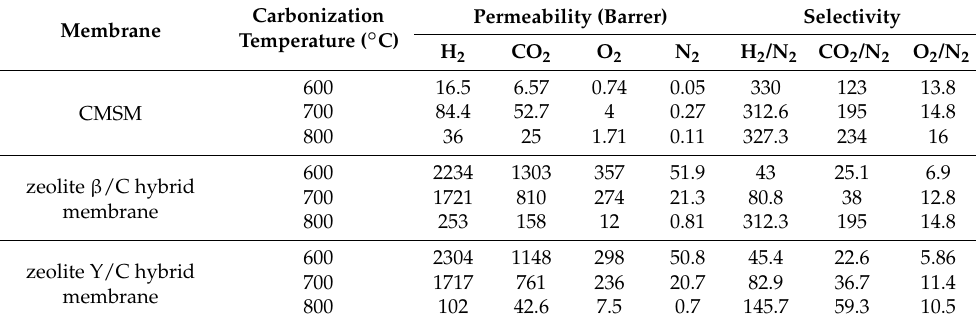
Table 7. The effect of carbonization temperature on the gas separation performance of the zeolite/C hybrid membranes and pure CMS membrane